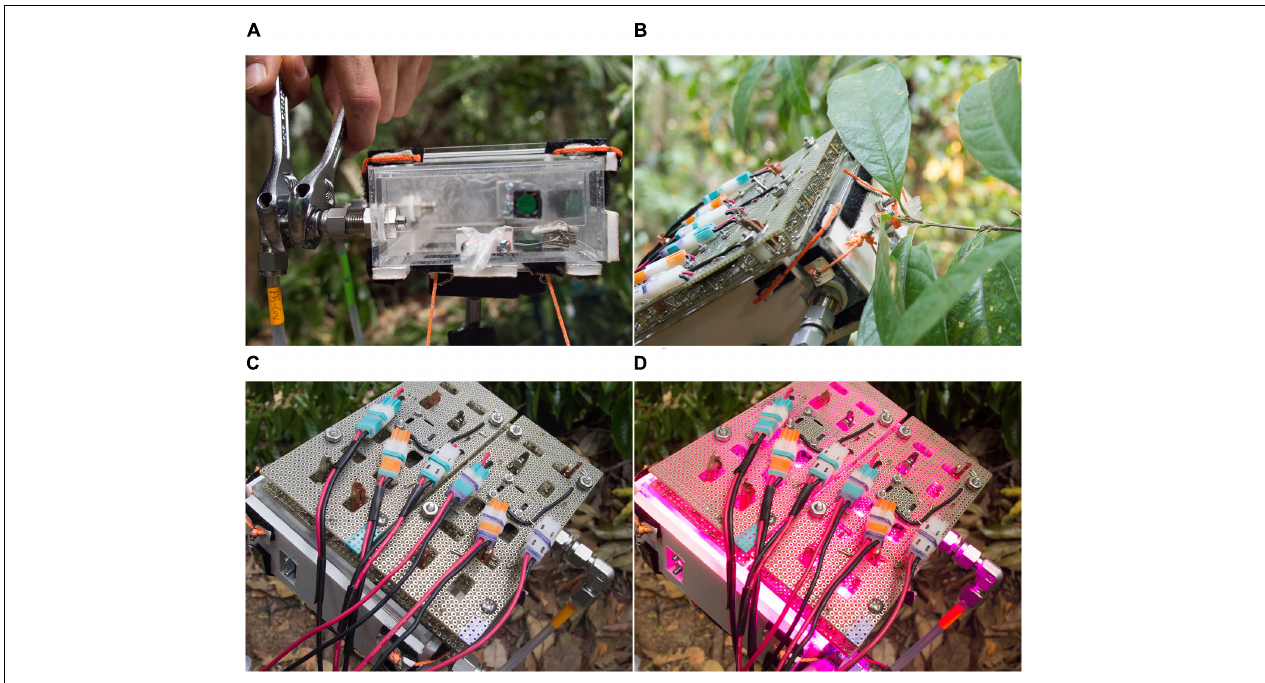
FIGURE 11 | To measure emissions from a leaf, the appropriate cuvette is chosen (A) , maximizing the amount of leaf area relative to cuvette volume. The leaf is installed while still attached to its branch, and the cuvette faceplate fixed with the petiole gasket loosely sealed around the leaf petiole (B) . The leaf sits in darkness until ambient air is cleared ( C , the ‘dark-leaf blank’ period in Figure 10 ). Then the lights are switched on, set to deliver 1000 µ mol m − 2 s − 1 PAR (D)